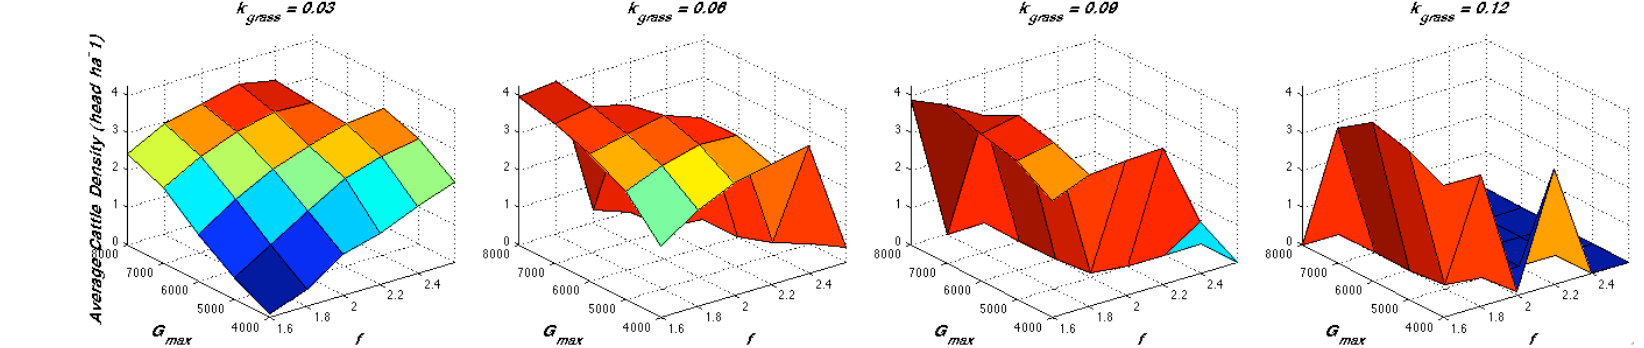
(kg/ha), scalar stocking factor f, and maximum intrinsic grass max